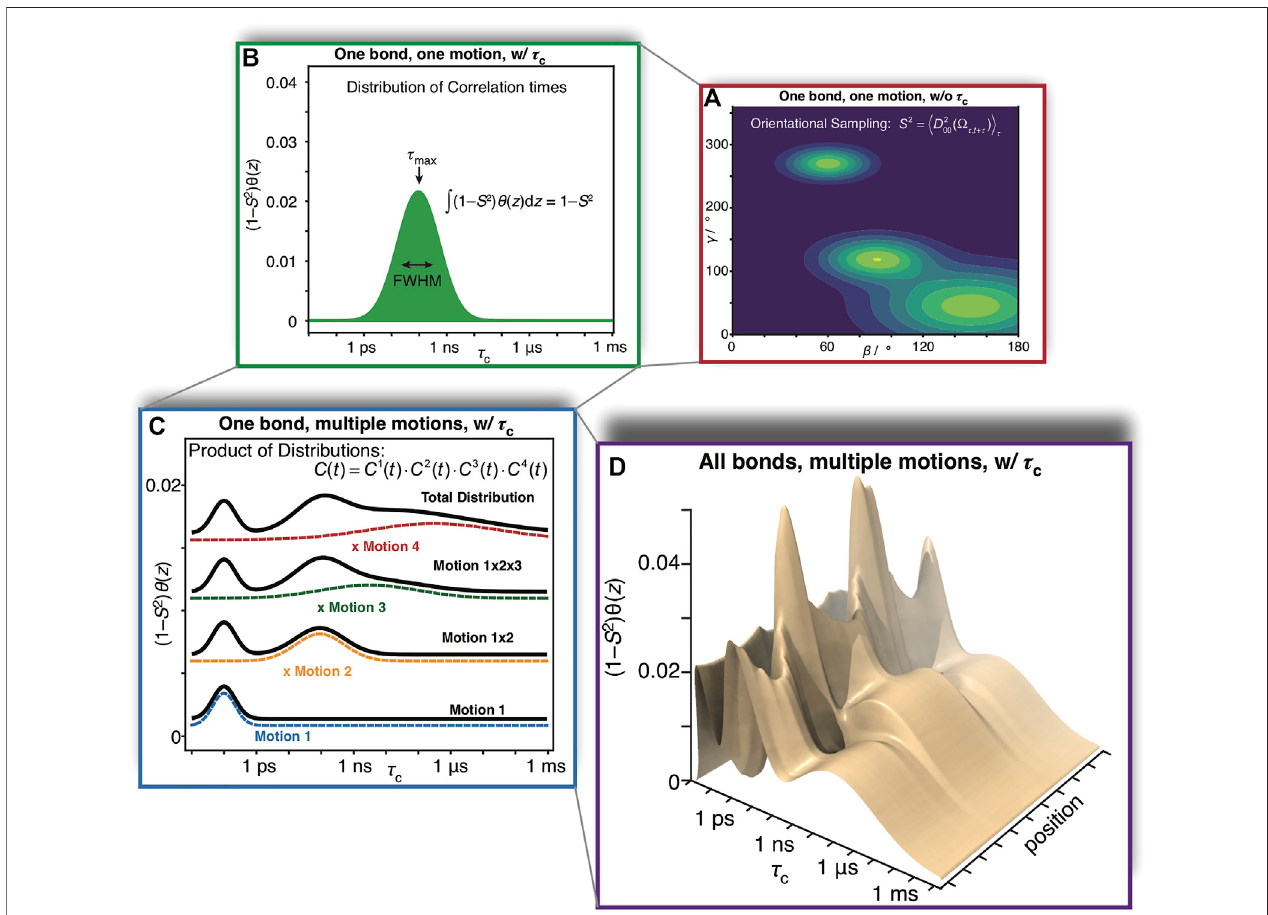
FIGURE1 | Complexity ofreorientationaldynamics. Foreach bond in amolecule, multiple types ofmotion result in orientational sampling, where the distribution of anglesforeachmotionresultinageneralizedorderparameter, S 2 .Therefore,in (A) weplotapossibledistributionofEuleranglesforasingletypeofmotion(populationis plottedasafunctionofangles β and c ,where α isnotrequiredforasymmetricinteractiontensor).Asinglemotionisfurthermoredescribedbyacorrelationtime,andmay be distributed over a range of correlation times. In (B) we plot a possible distribution of correlation times ( 1 − S 2 ) θ ( z ) , that is, amplitude of motion as a function of the log-correlation time, z (cid:2) log 10 ( τ c /s ) . Each distribution is characterized by an amplitude, center, and width. Note that the integral of the distribution is ( 1 − S 2 ) , S 2 being determined bythe distribution ofangles in (A) .While (A,B) illustrate aspects ofa single motion, multiple motions in fl uence a givenbond,where the total correlation functionistheproductofindividual correlationfunctions. In (C) ,weplotfour distributionsofmotion (color).Above each motion, weplotthedistributionresultingfrom the product of that motion and all motions below it (black), eventually resulting in the total distribution seen at the top. Finally, we note that the total distribution varies as a functionofpositioninthemolecule,resultinginthe3Dplotofthedistributionasafunctionofcorrelationtimeandpositioninthemoleculeobservedin (D) .Whilethisisjust an illustration, one could imagine that motion in (D) results from three α -helices in a protein, each having a slightly different behavior, and varying dynamics as one approaches the end of each